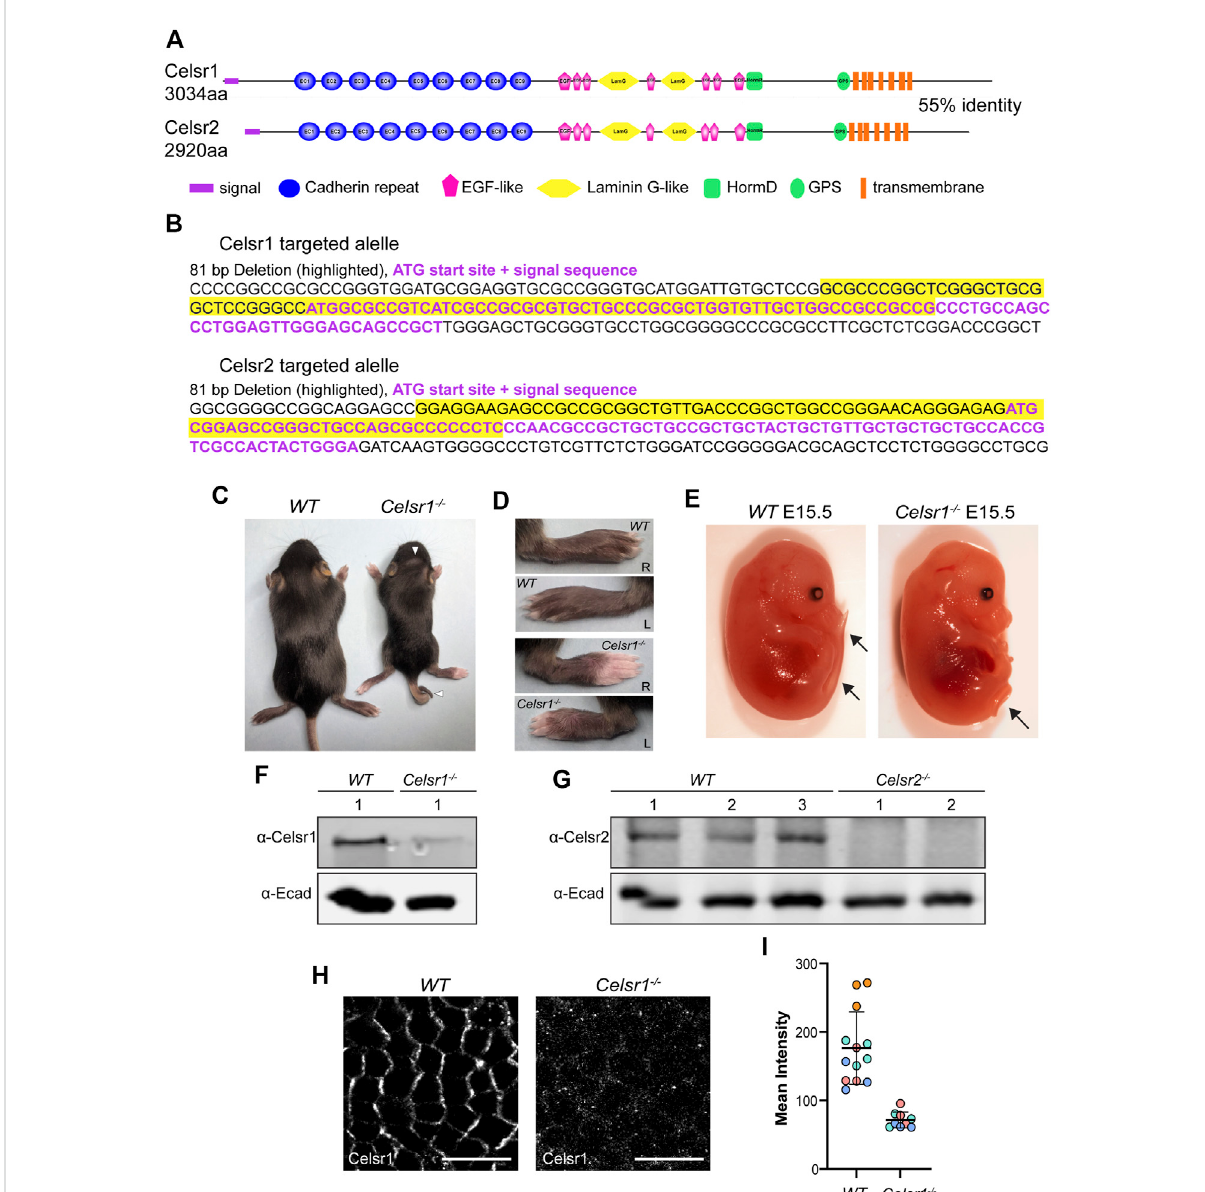
Generation of Celsr1 and Celsr2 loss-of function mutant mice by CRISPR/Cas9. (A) Schematic representation of Celsr1 and Celsr2 protein domains. The two proteins are 55% identical in amino acid sequence and have the same overall domain organization. (B) CRISPR-Cas9 targeting of Celsr1 and Celsr2 genomic loci. Guide RNAs were targeted to the sequence encoding the signal peptide for each of Celsr1 and Celsr2 . The resulting targeted alleles are shown with the ATG and signal sequence in purple font and deleted sequences highlighted in yellow. (C) Celsr1 − / − and wild type ( WT ) littermate at P12. Note curly tail and whorled hair pattern on the head of Celsr1 − / − homozygote. (D) Left and right paws of Celsr1 − / − and WT littermate at P12. Celsr1 − / − homozygotes exhibit prominent hair whorl on each paw. (E) Celsr1 − / − and WT littermate embryos at E15.5. Celsr1 − / − homozygotes display curly tail. (F) Western blot of epidermal lysates from WT and Celsr1 − / − P0-P3 backskins with anti-Celsr1 antibody. (G) Western blot of epidermal lysates from three individual WT and two individual Celsr2 − / − P0-P3 pups with anti-Celsr2 antibody. (H) Confocal immuno fl uorescence image of whole mount epidermis from E15.5 WT and Celsr1 − / − mutant embryos labeled with Celsr1 antibodies. Scale bars: 10 µm. (I) Quanti fi cationofCelsr1mean fl uorescenceintensityin WT and Celsr1 − / − mutantepidermis(n=3skinregionsfrom4differentWTembryos and n = 3 skin regions from 3 different Celsr1 − / −